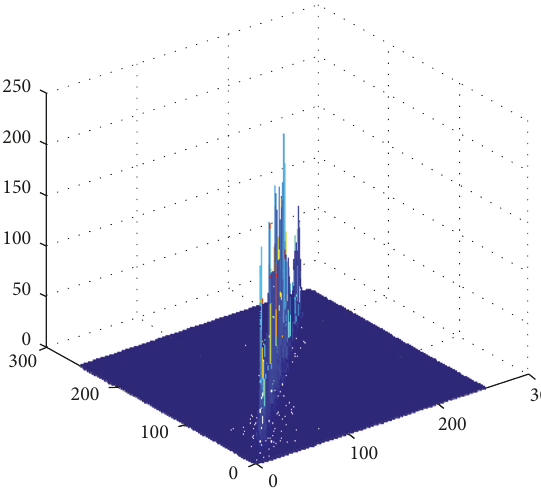
Figure 1: Two-dimensional histogram of an image histogram.